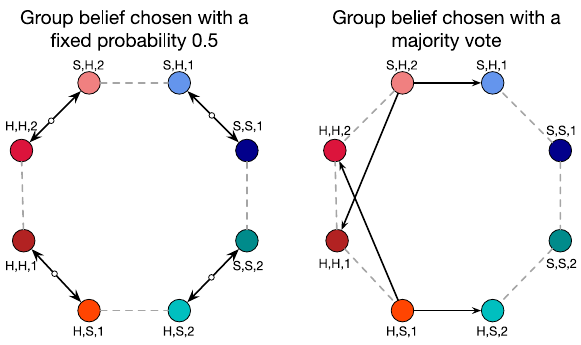
Fig. 3 Dynamics on the edges of the simplex for alternative consensus making processes. Left. Instead of a frequency-dependent process as in